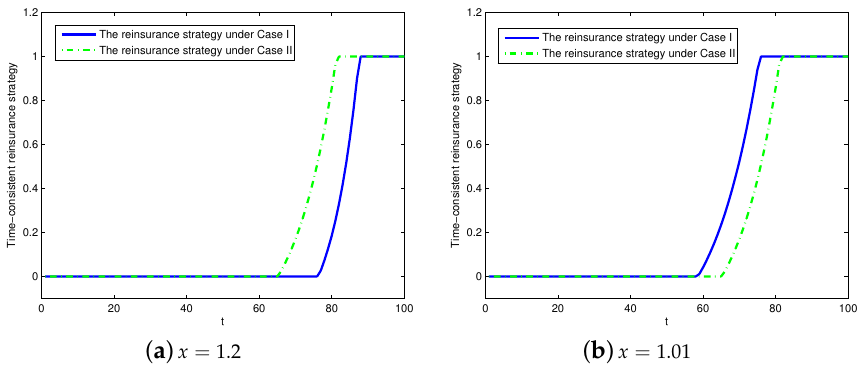
Figure 6. Nash equilibrium reinsurance strategy under the expected value premium principle ( α =